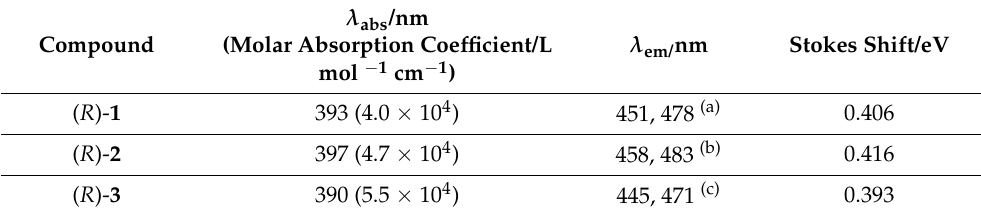
Table 2. Spectroscopic properties of ( R )- 1 , ( R )- 2 , and ( R )- 3 in a dilute THF solution (10 µ M).